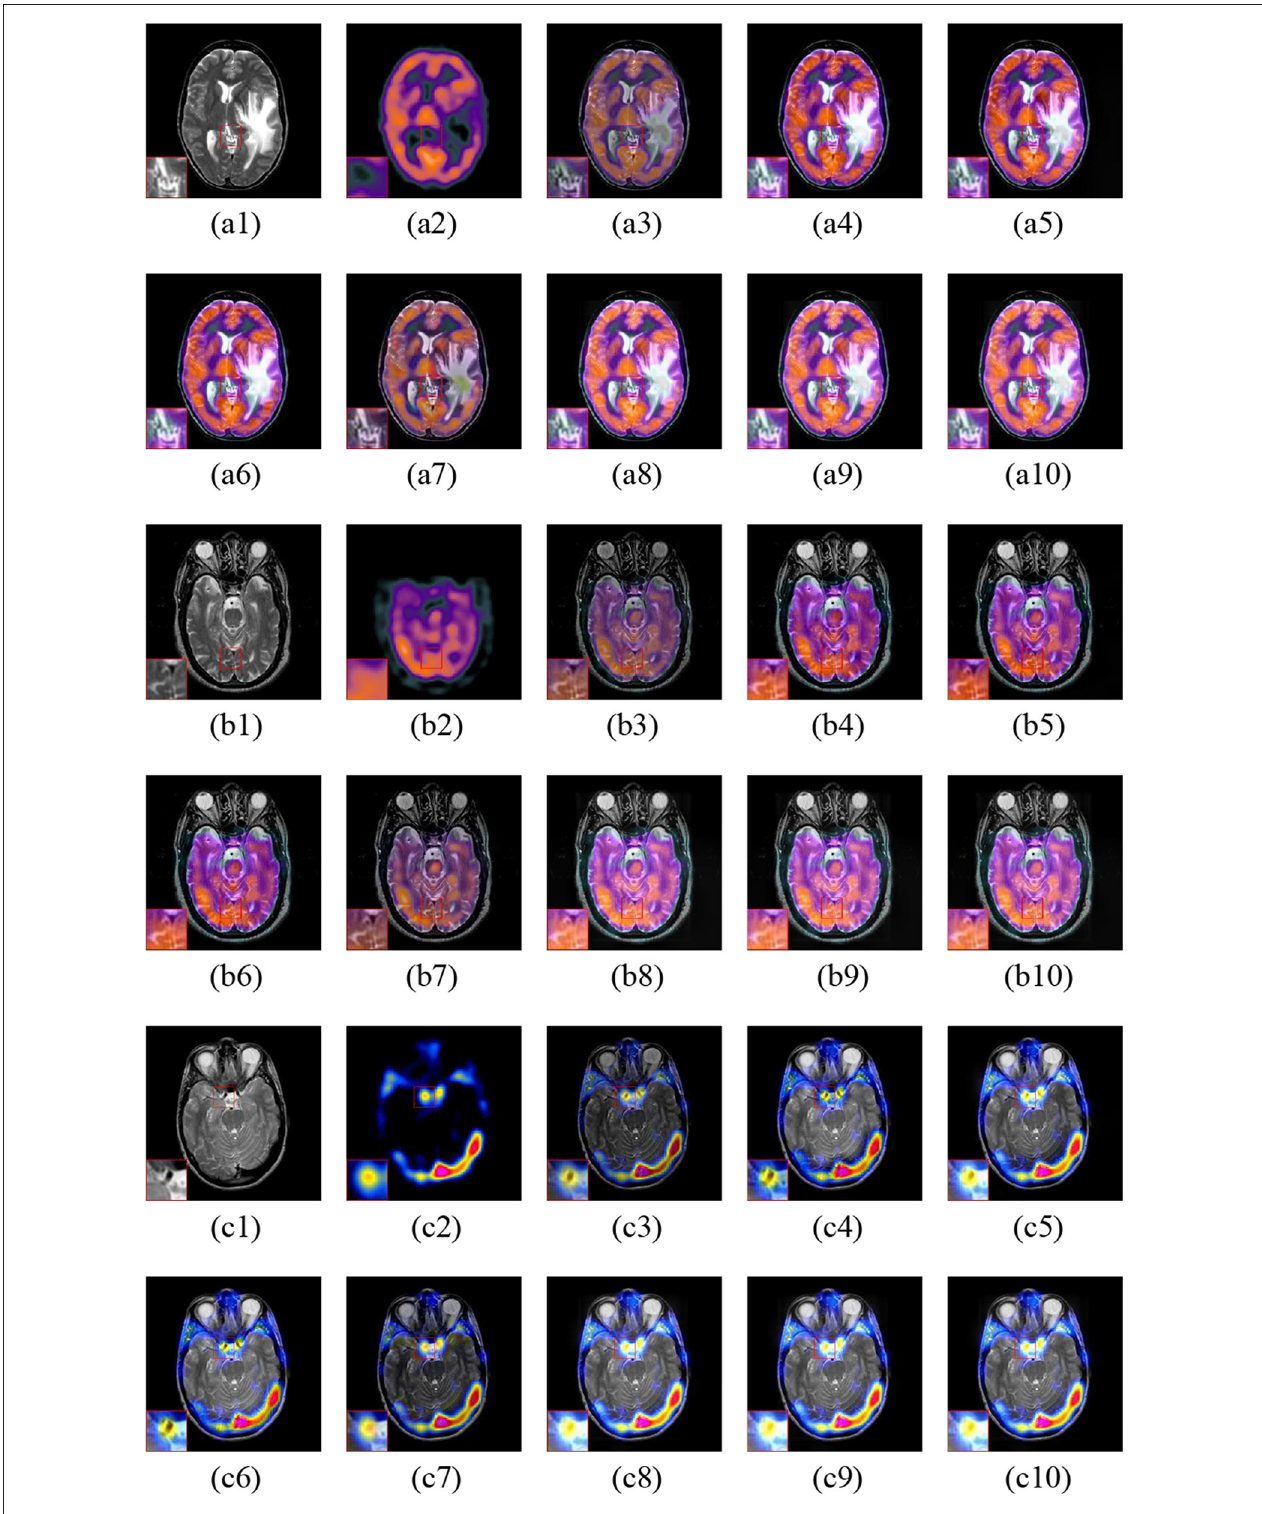
FIGURE 9 | Three fusion examples of MR and SPECT images. One close-up is provided in each set for better comparison. The original images: (a1–c1) MR and (a2–c2) SPECT. The fusion results: (a3–c3) ASR, (a4–c4) NSCT-PC-LLE, (a5–c5) LP-CNN, (a6–c6) NSST-PAPCNN, (a7–c7) CSMCA, (a8–c8) LatLRR-FCN-32s, (a9–c9) LatLRR-FCN-16s, and (a10–c10) LatLRR-FCN-8s.